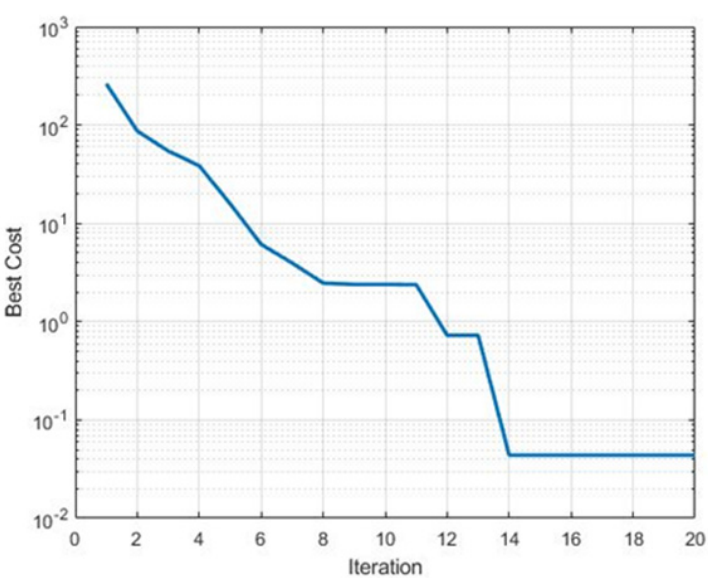
Figure 9. Global best cost value over several iterations for the previous function.